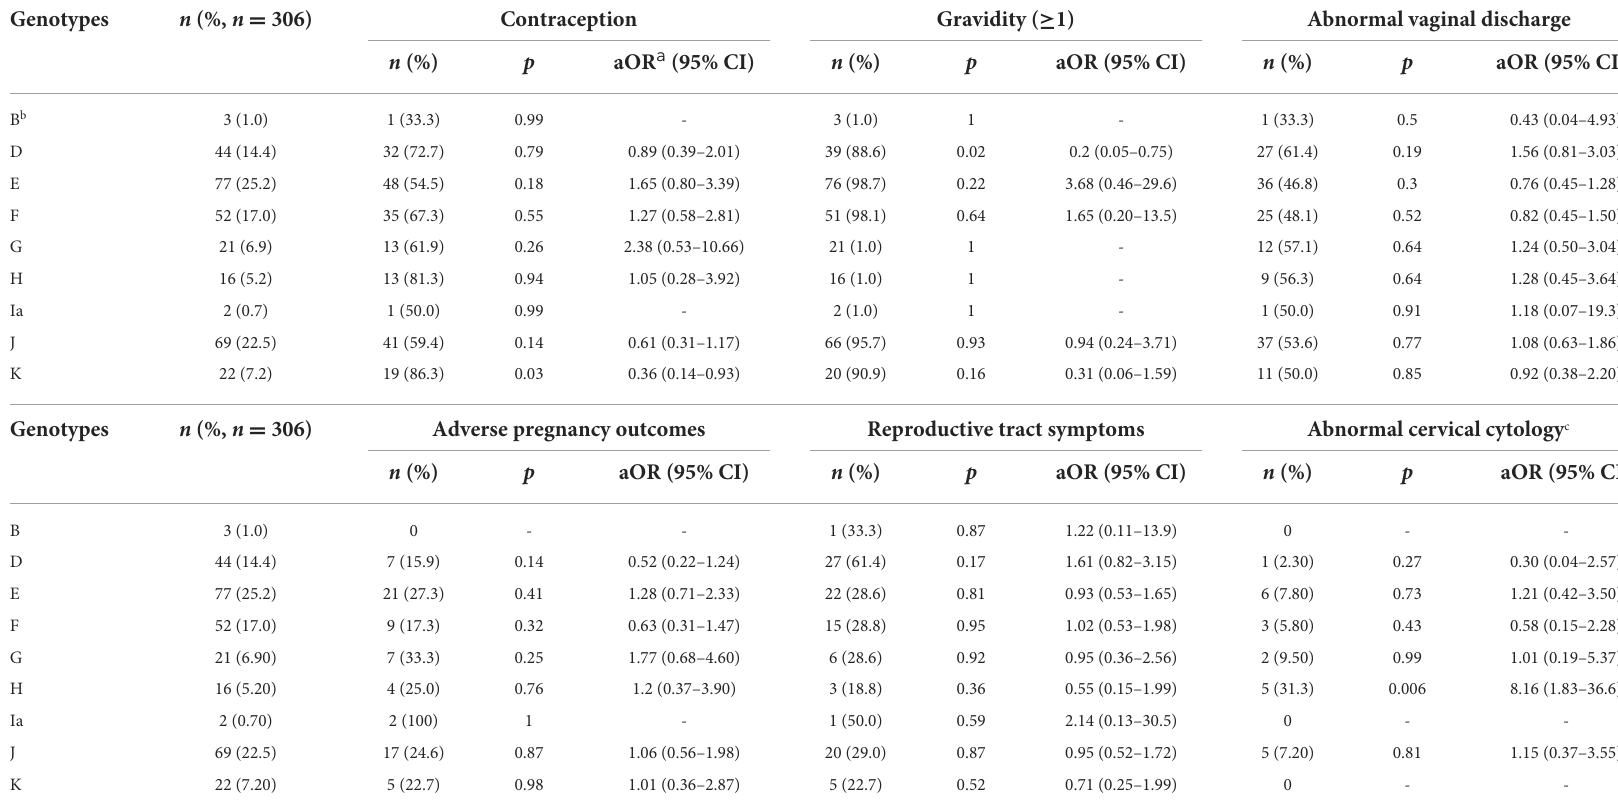
TABLE 4 Associations between C.trachomatis genotypes and clinical